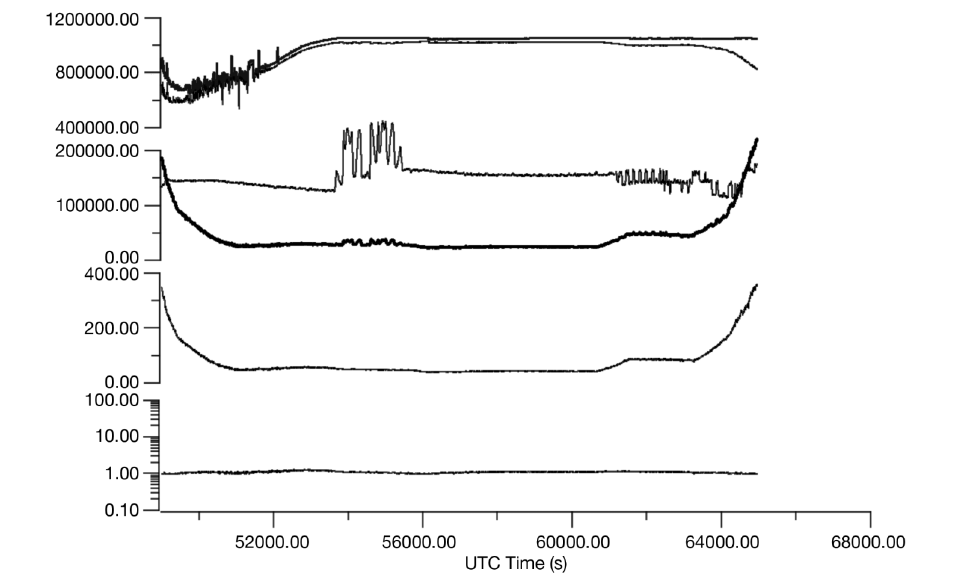
Fig. 5. MAS data stream. From above signal of the backscattered peak and background signal, laser monitor line, actual signal (peak-background) not yet corrected for the laser power variations, corrected signal and final- ly calibrated scattering ratio. In this case the absence of clouds is evidenced by the R